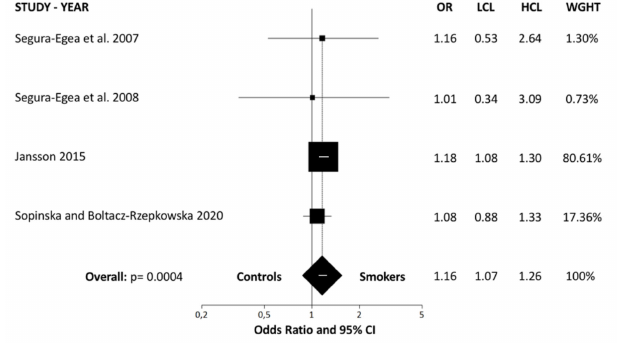
Figure 3. Forest plot of ORs and 95% confidence limits (CLs) for the comparison of smokers and healthy control subjects regarding the prevalence of root filled teeth (RFT) with radiolucent periapical lesions (RPLs). Overall estimate is based on data from the four studies. Black squares represent the point estimates of the OR and have areas proportional to study size. Lines represent 95% confidence intervals. The diamond shows the summary statistics for the four studies. The solid line indicates an OR of 1.0, and the dashed line indicates the overall odds ratio. OR: odds ratio; LCL: lower confidence level; UCL: upper confidence